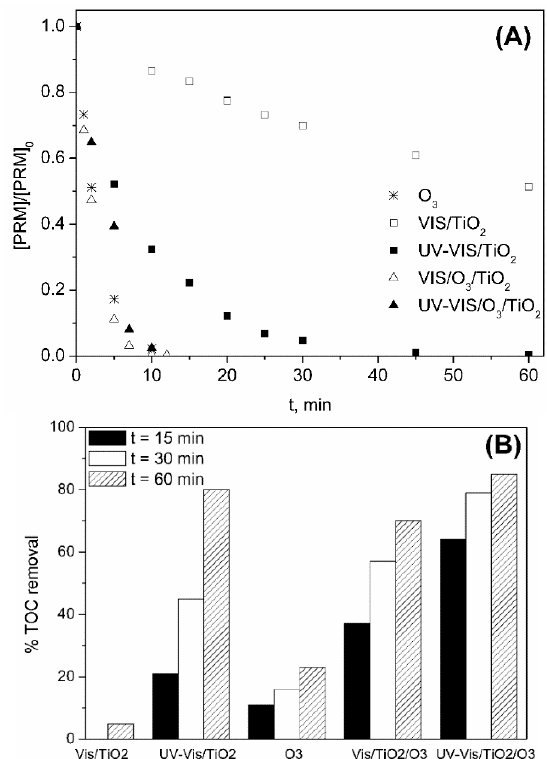
Figure 4. Variation with time of PRM normalized concentration ( A ) and percentage of TOC removed ( B ) during the application of different processes in ultrapure water. Experimental conditions: [PRM] 0 = 5 mg L − 1 ; [TOC] 0 = 3.3 mg L − 1 ; [TiO 2 ] = 0.25 g L − 1 ; pH 0 ~6 (natural pH); Q m,O3 = 3.3 mg min − 1 ; T = 20–30 °C; I Vis = 7.75 × 10 − 5 Einstein L − 1 s − 1 ; I UV-Vis = 8.2 × 10 − 5 Einstein L − 1 s − 1 .